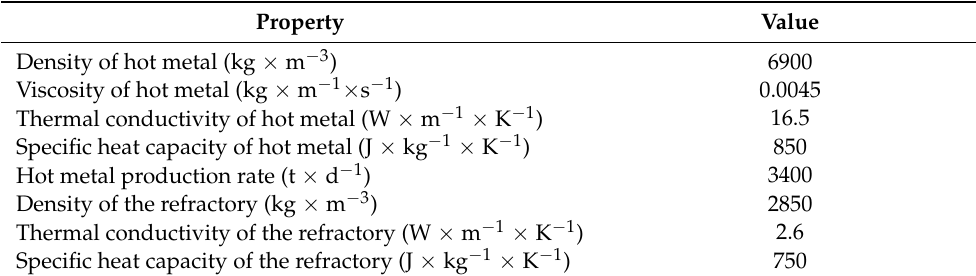
Figure 1. System studied and its dimensions in the simulation: ( a ) front view, ( b ) cross-section at inlet, ( c ) cross-section at outlet. Table 1. Physical parameters of the main trough.